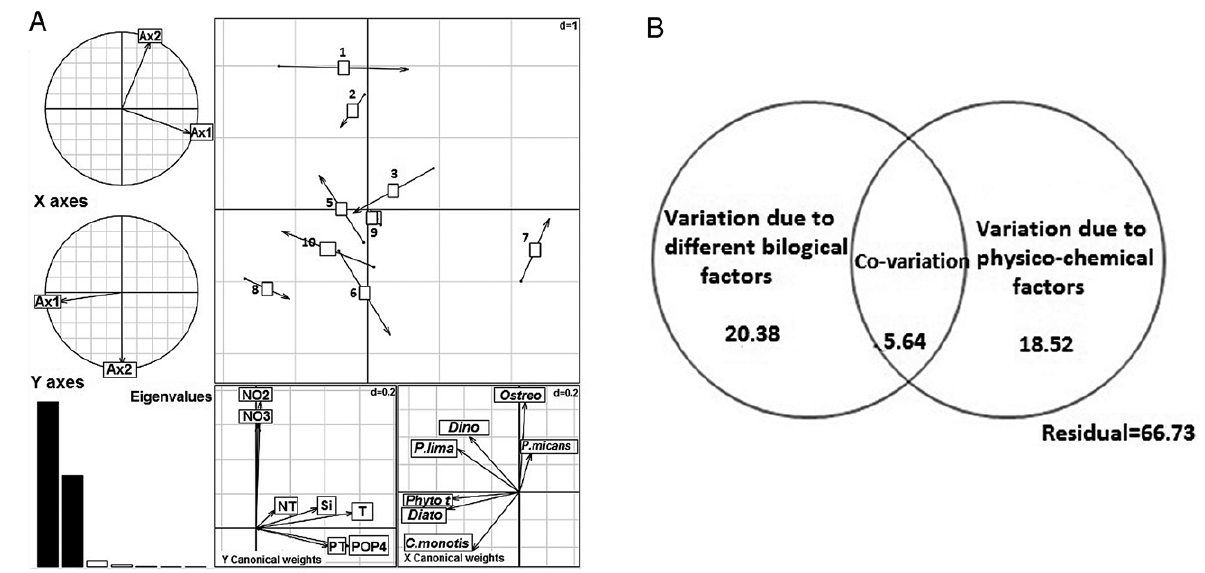
Fig. 2. – Co-inertia analysis of relationships between the relative abundance of epiphytic algae, substrates and environmental variable. 1, P. oceanica ; 2, C. mediterranea ; 3, P. pavonica ; 4, C. nodosa ; 5, H. stipulacea ; 6, D. dichotoma ; 7, D. membranacea ; 8, A. armata ; 9, P. capitatus ; 10, Z. noltii ; Dino , dinoflagellates; Diato , diatoms; Ostreo , Ostreopsis cf. ovata ; Phy t , total phytoplankton. Table 4. – Occurrence frequency of dinoflagellates (relative to total dinoflagellates) on P. oceanica and in its water column and their eco- logical characteristics (*, toxic; **, potentially toxic; a,b,e , according to Abdennadher (2014); d , according to Pagliara and Caroppo (2012); c , according to Calabretti et al. (2017), David et al. (2017), Abdennadher (2014). Species